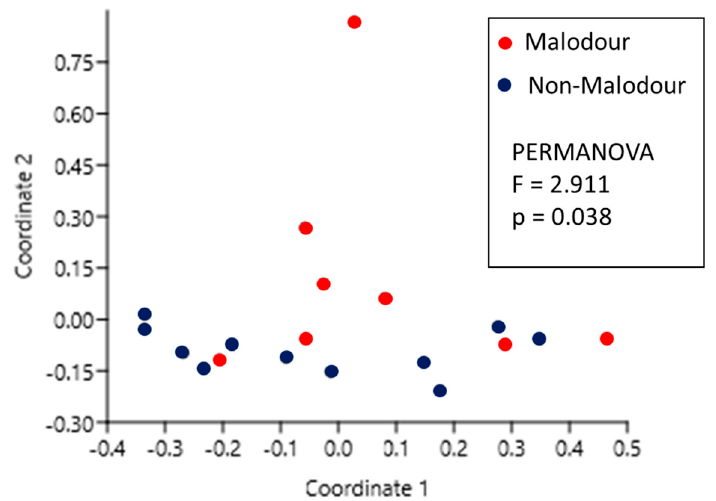
Figure 3. Principal coordinates analysis (PCoA) comparison between the microbial population of malodor and non-malodor groups.